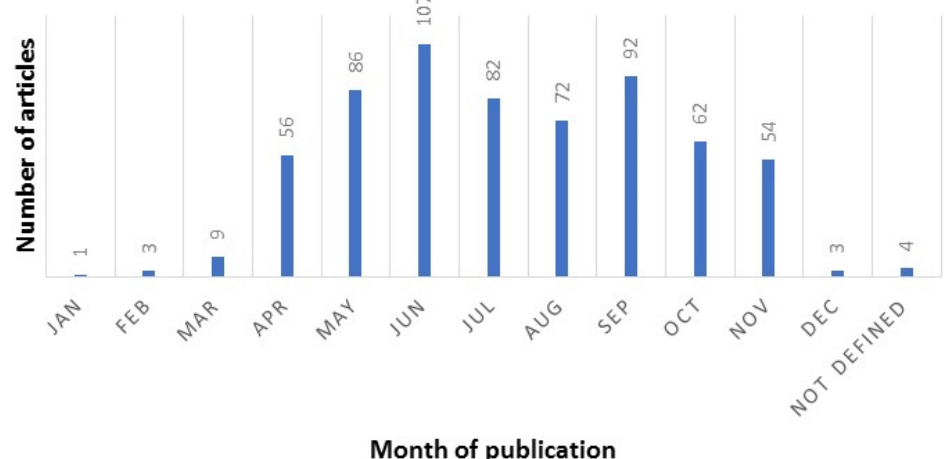
Figure 4. Frequency of articles published in different months.